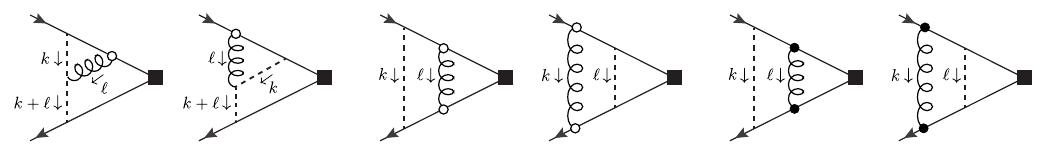
Figure 8 . Feynman diagrams for two-loop corrections to the NRQCD LDMEs that produce log- arithmic UV divergences. There are additional diagrams that can be obtained from charge conju- gation, which we do not show here. Solid lines are heavy quarks and antiquarks, dashed lines are temporal gluons, and curly lines are transverse gluons. Open and filled circles represent insertions of the p · A vertex and the spin-dependent σ · B vertex, respectively. Filled squares represent the operator χ † (cid:15) · σ ψ for spin triplet, and χ † ψ for spin